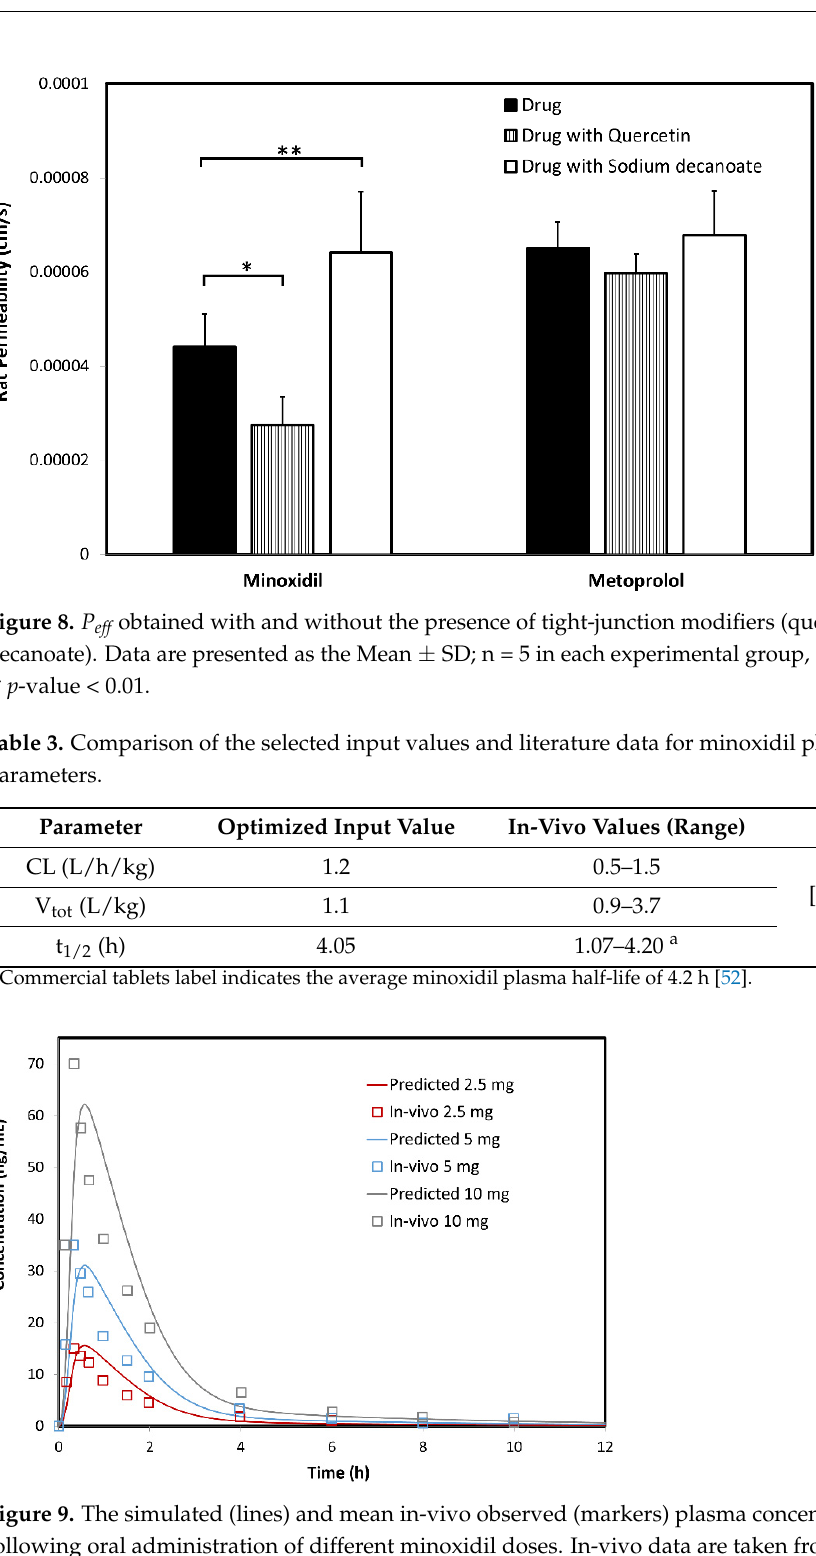
Figure 7. The effective permeability values ( P eff ; cm/s) obtained for minoxidil and metoprolol after in ‐ situ single ‐ pass perfusion to the rat proximal jejunum at pH 6.5, mid ‐ small intestine at pH 7.0, distal ileum at pH 7.5, and to the colon at pH 6.5. Data are presented as the mean ± SD; n = 5 in each experimental group.